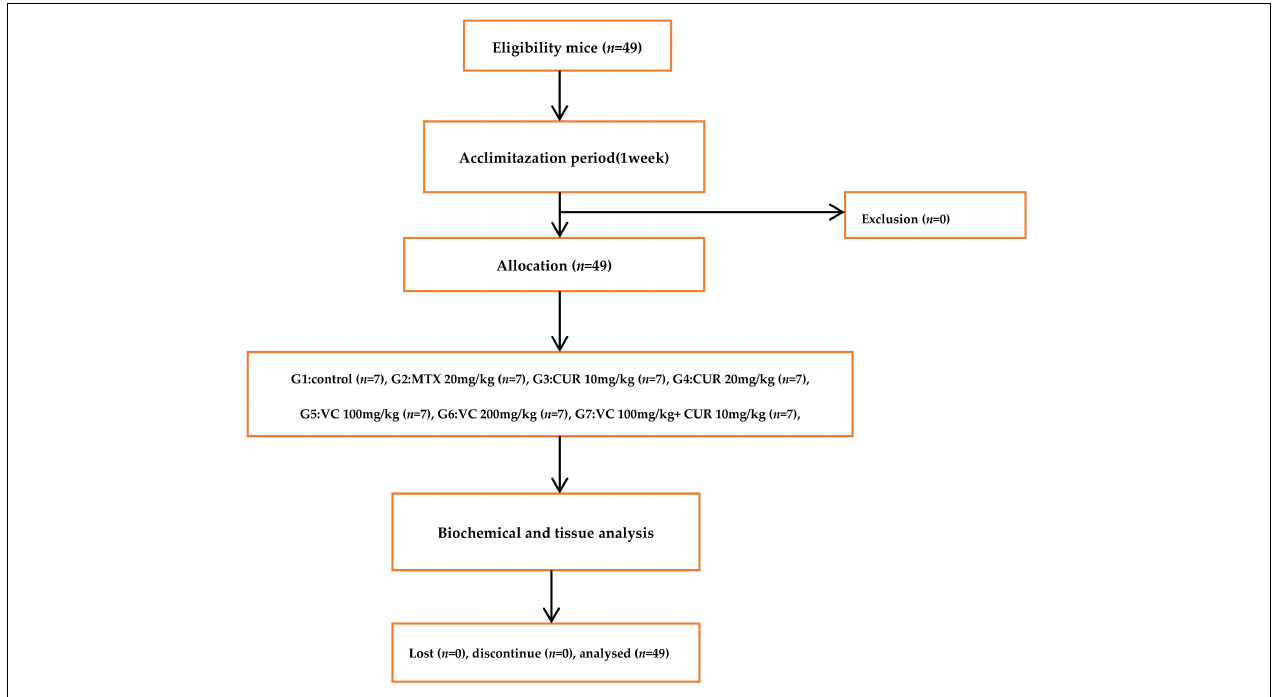
FIGURE 1 | Consort-flow diagram of the